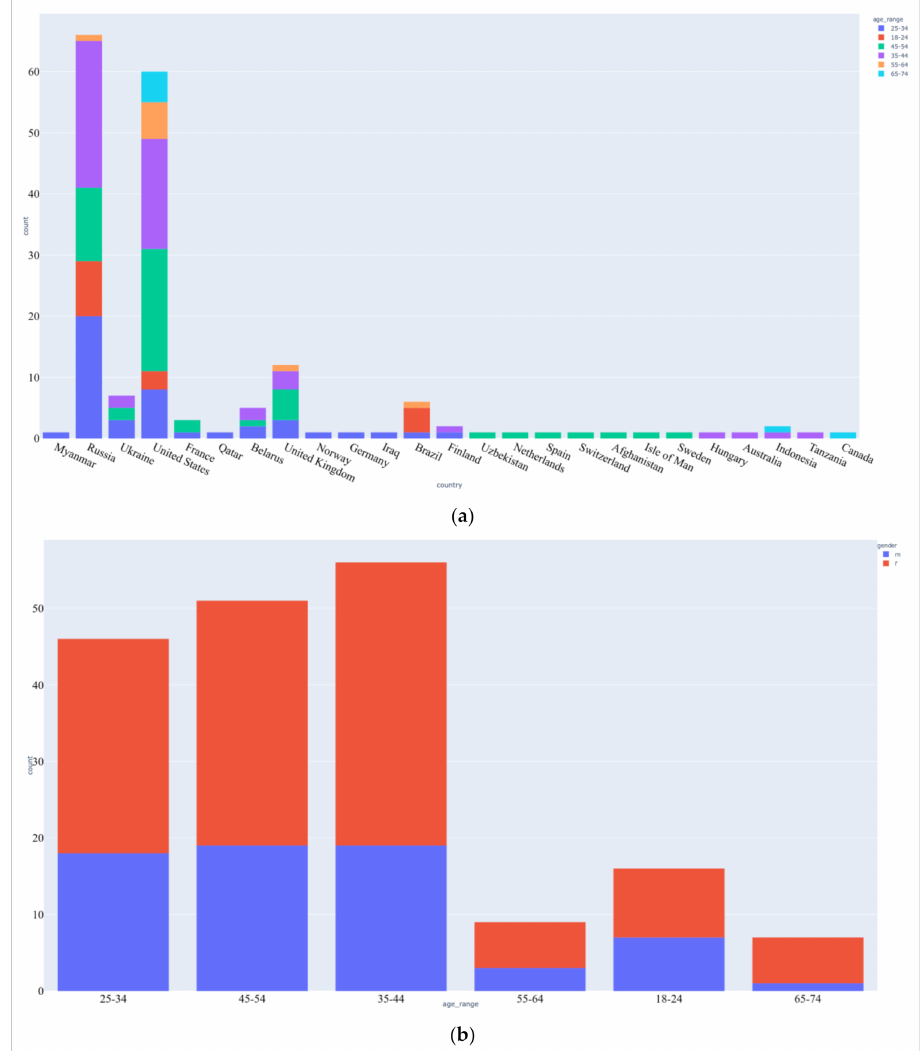
Figure 4. The distribution of the participants over their ( a ) age groups and countries of residence and ( b ) gender and age